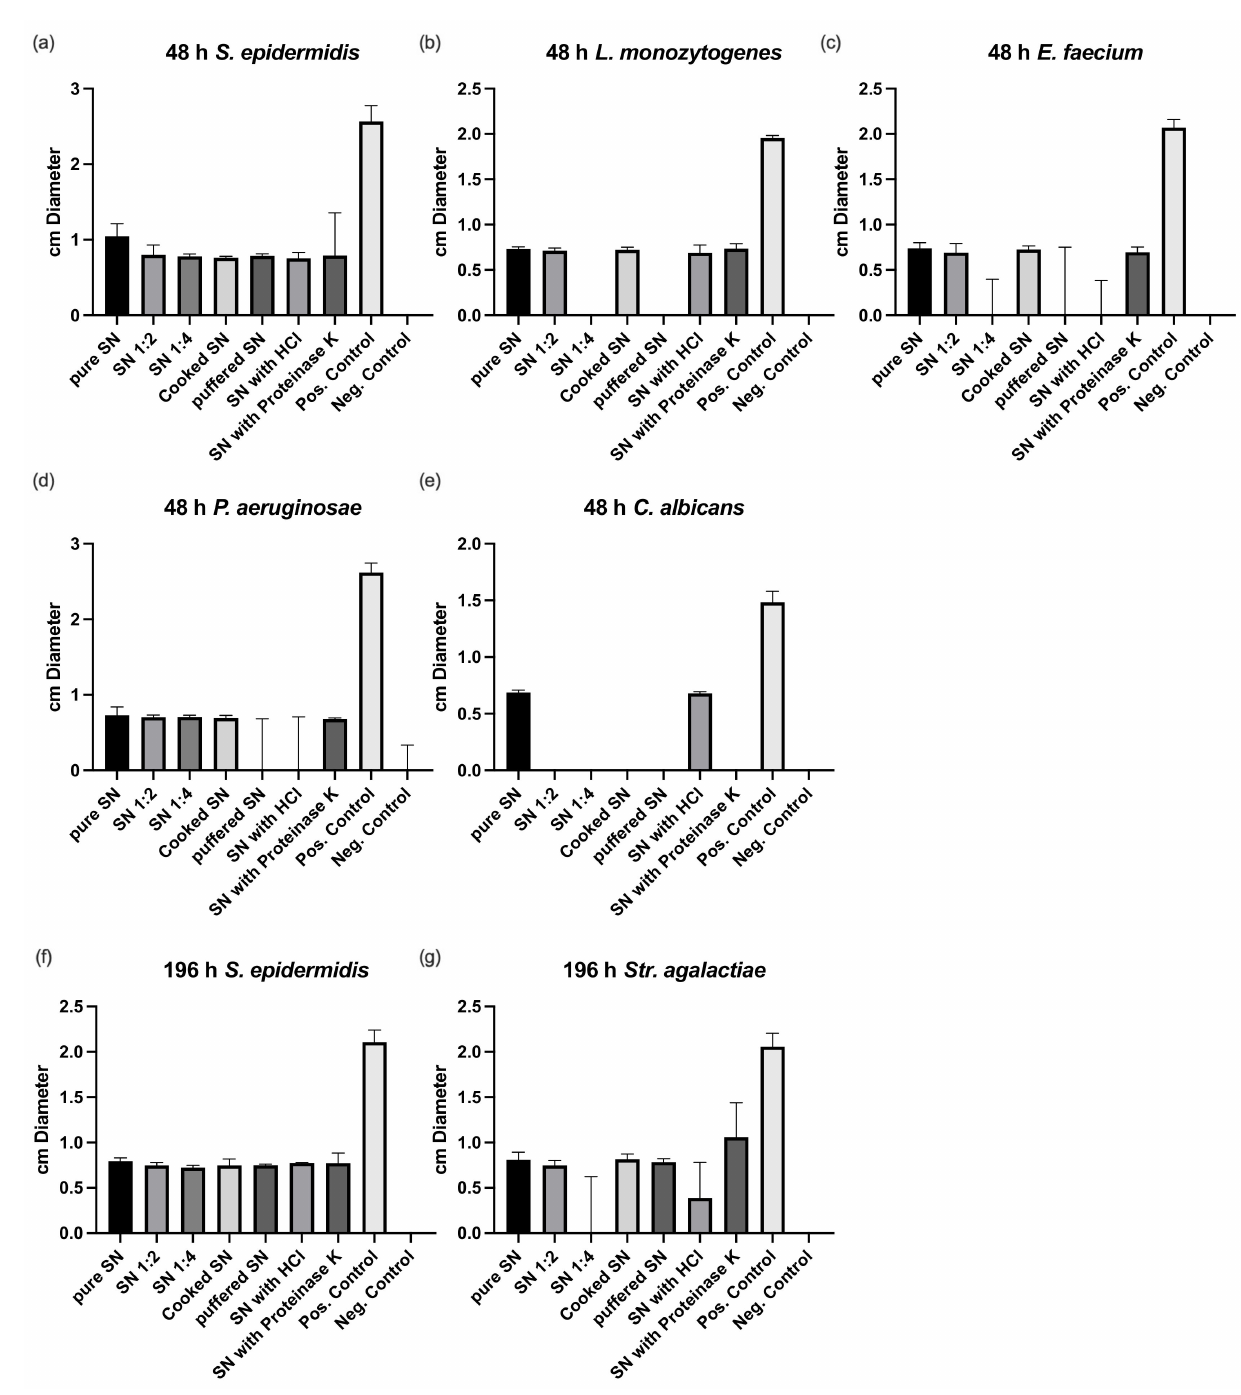
Figure 2. Susceptibility testing of culture supernatant after 48 ( a – e ) and 196 h of culture ( f , g ). SN, supernatant; HCl, hydrochloric acid. Pos, positive; Neg,